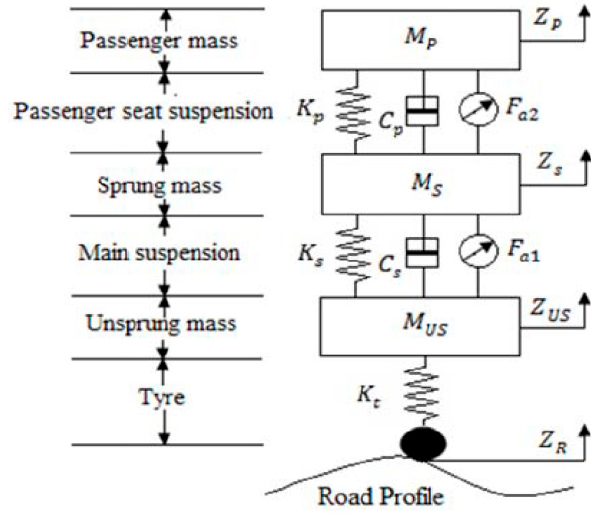
Figure 6. Integrated active quarter suspension and seat suspension system [64]. Table 2. Summary of the current active seat suspension systems in multiple vibration